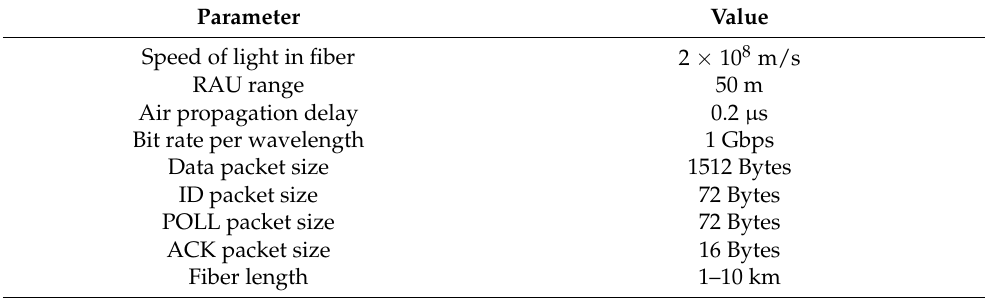
Table 2. Simulation